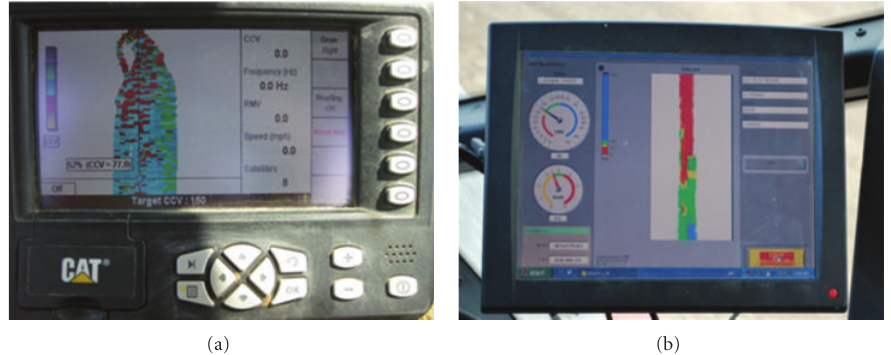
Figure 1: Photographs of on-board display units by Caterpillar (a) and Dynapac